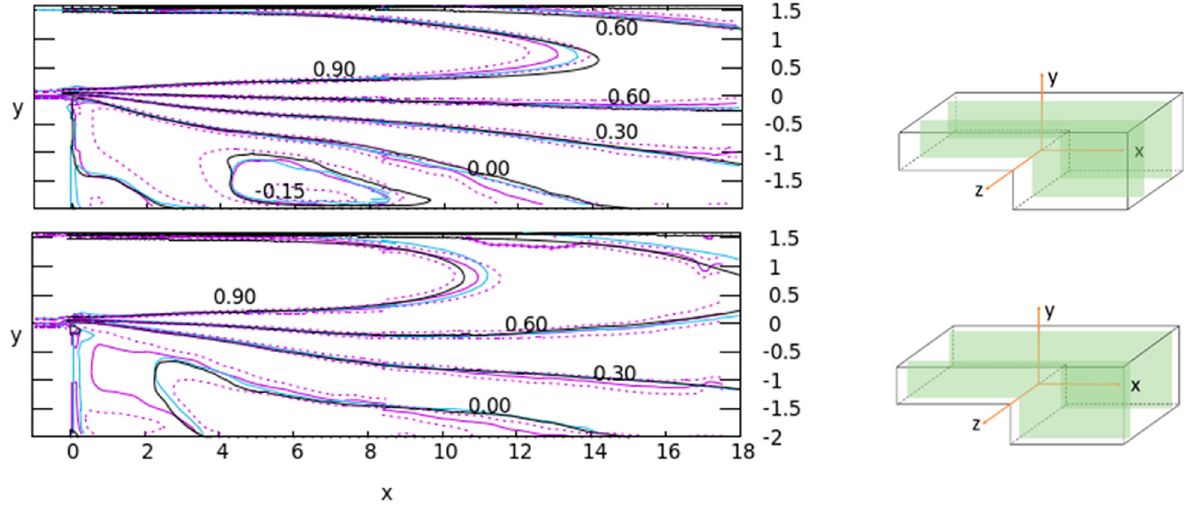
Figure 7. Flow symmetry: time-averaged u velocity contours. Top: measurements ‘z − 0.8’ (violet) and ‘z+0.8’ (blue). Bottom measurements ‘z − 1.36’ (violet), ‘z+1.36’ (blue). DNS—black contours. Dotted violet contours: sensitivity contours at ±0.03 units of ‘z − 0.8’ (top) and ‘z − 1.36’ (bottom) cases.